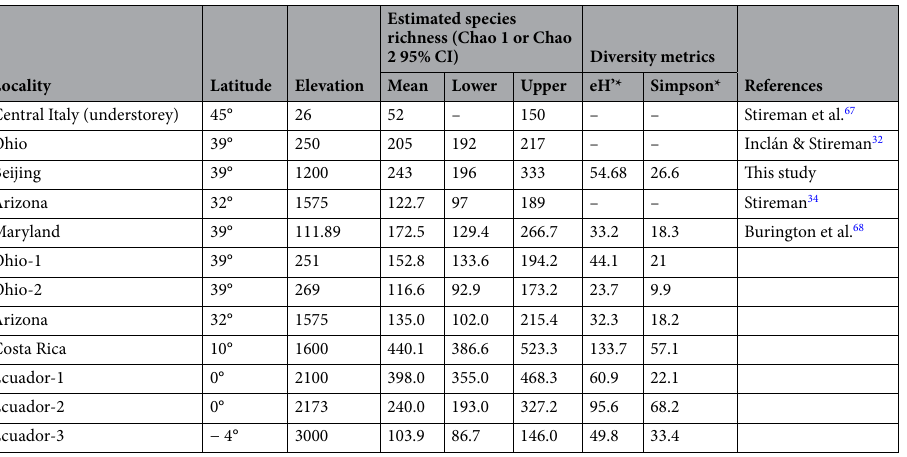
Table 3. Summary information of tachinid species richness estimates from different zoogeographical